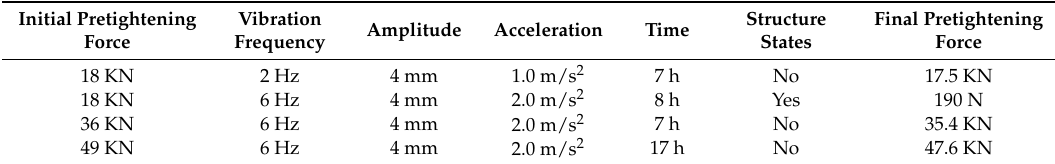
Table 1. Four groups of vibrational parameters.